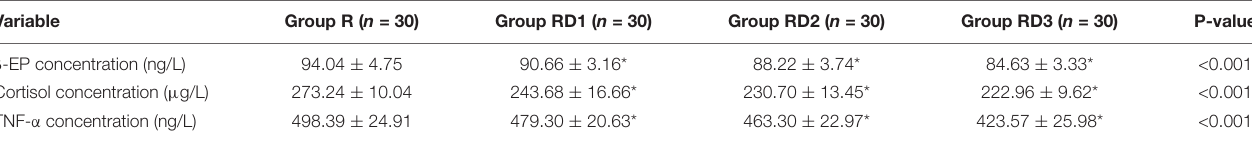
TABLE 5 | The postoperative concentrations of β -EP,Cortisol and TNF- α .